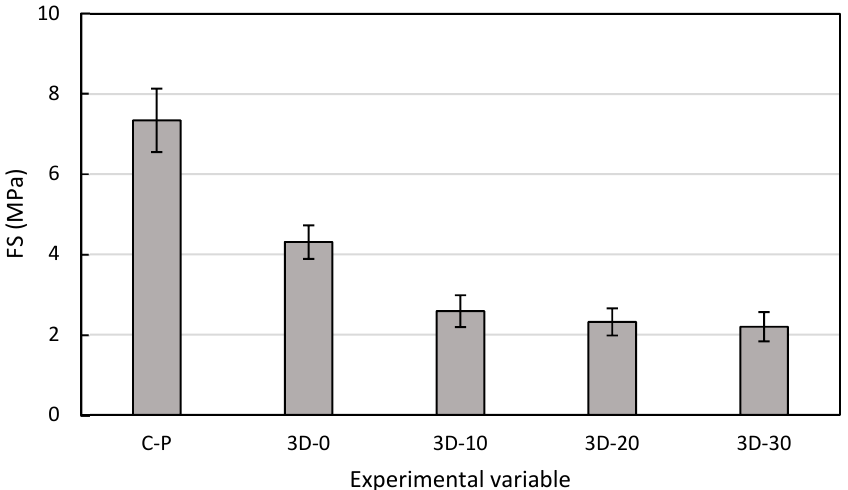
Figure 9. 28-day Flexural strength of reference and 3DCP for each experimental pass time.